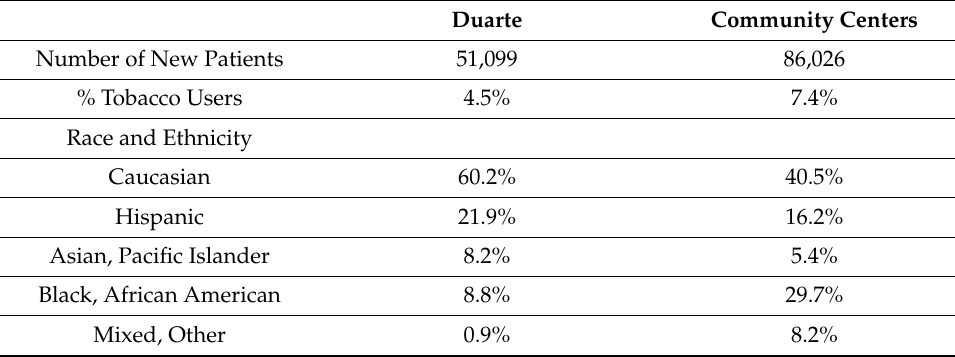
Table 1. Characteristics of City of Hope Patients